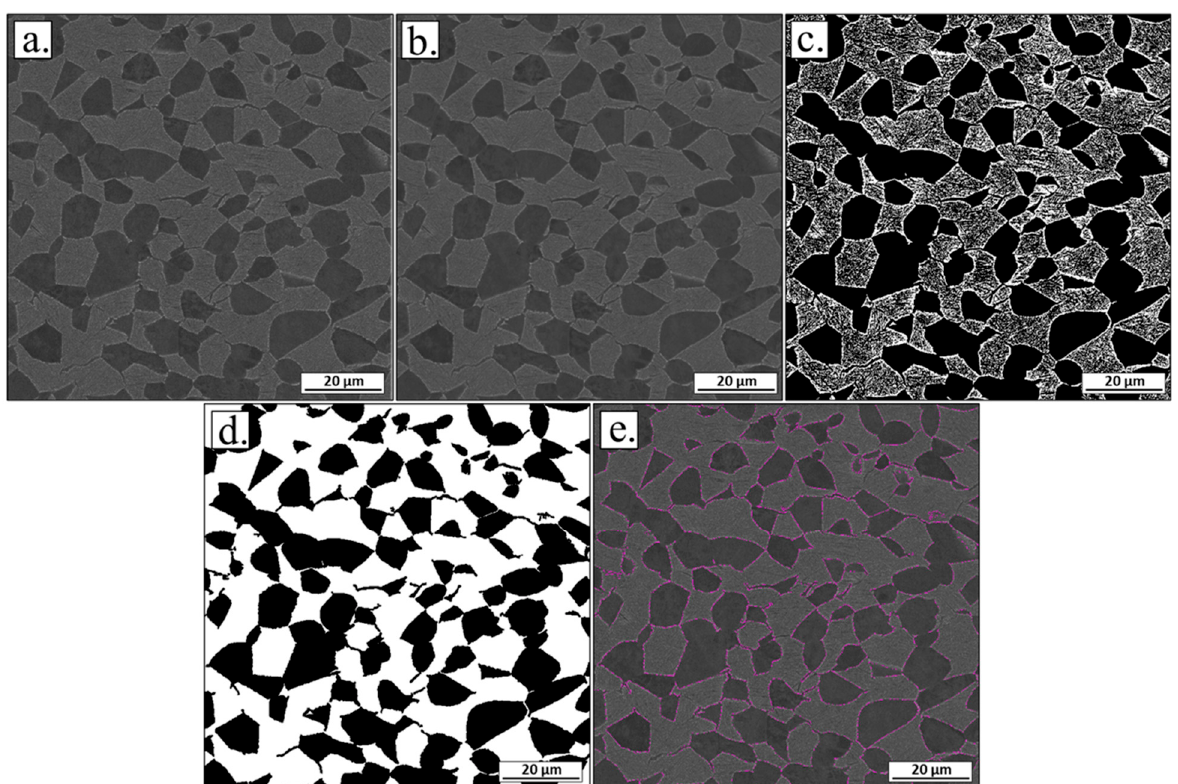
Figure 2. Segmentation workflow applied on a BSE micrograph with view-field of 100 µm. ( a ) Raw image from the scanning electron microscope device. ( b ) Image after a gaussian global noise removal correction. ( c ). Resulting micrograph after the thresholding step. ( d ) Final segmented microstructure representative. ( e ) Original image with the phase boundaries highlighted in magenta for the visual validation of the segmentation process.